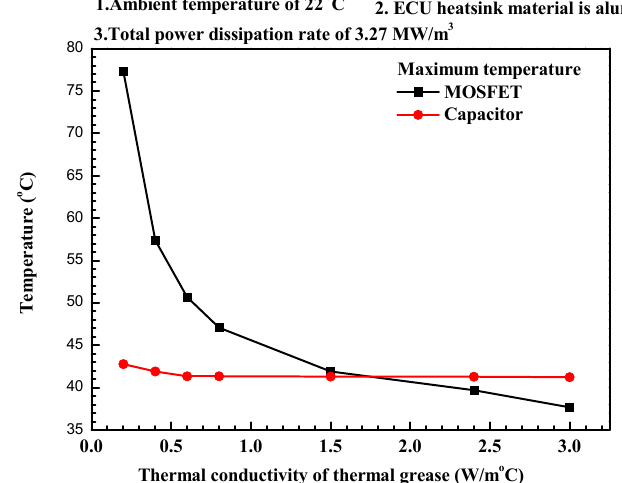
Figure 8. Variation of the temperatures of the MOSFET and the capacitor of the 36V ECU system with the thermal conductivity of the thermal grease.